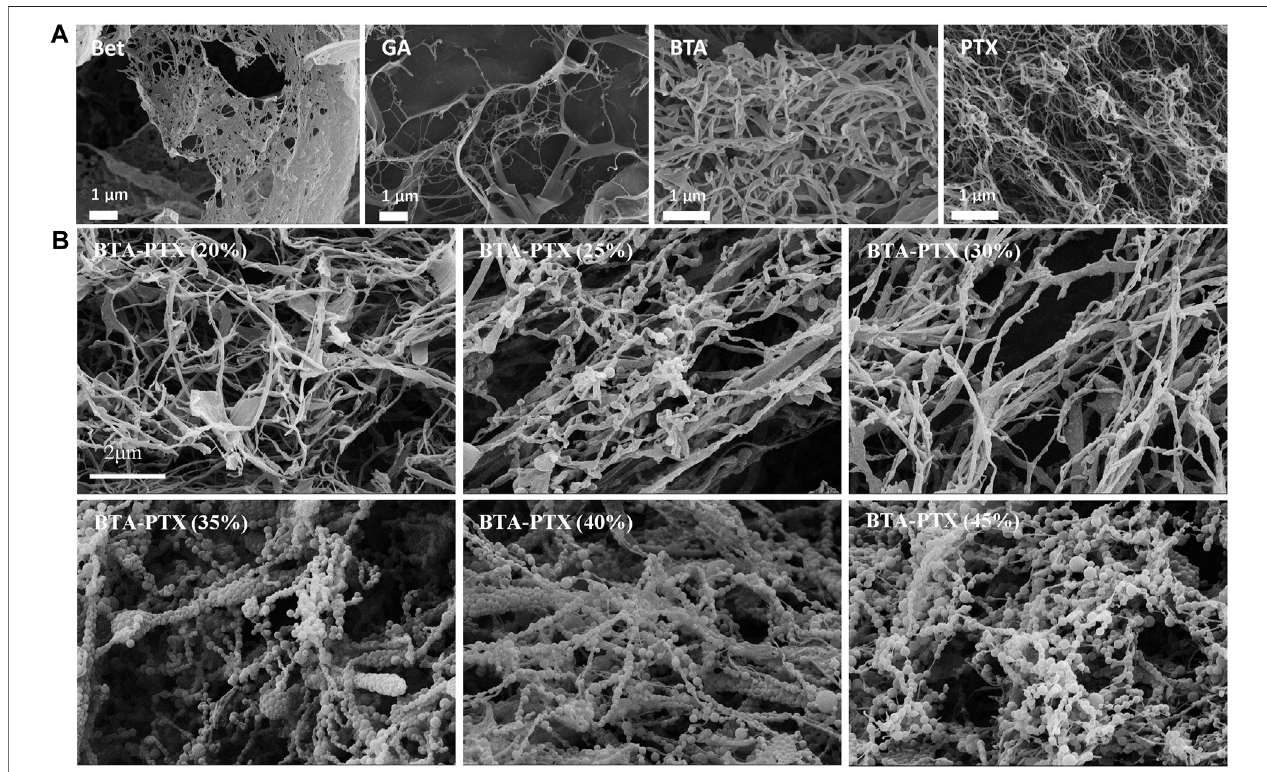
FIGURE 5 | SEM images of NPs (Wang et al., 2020b). (A) SEM images of BTA, GA, BTA and PTX self-assemblies NPs. Self-assembly morphologies of GA, BTA, Bet and PTX are nano fi bers with particle diameters greater than 600 nm. (B) Effect of BTA and PTX interaction at different ratios on the morphology of NPs. As the increaseofPTX,thehybridNPsgraduallychangesfromnano fi berstonanospheres.WhenthemassratioofPTXisgreaterthan35%,thesphericalmorphologygradually decreases and gradually transforms into nano fi bers. Abbreviations: Bet: botulin; GA: glycyrrhetinic acid; BTA: Betulonic acid; PTX: paclitaxel; BTA-PTX: Co- assembled NPs formed by the interaction of BTA and PTX (different mass